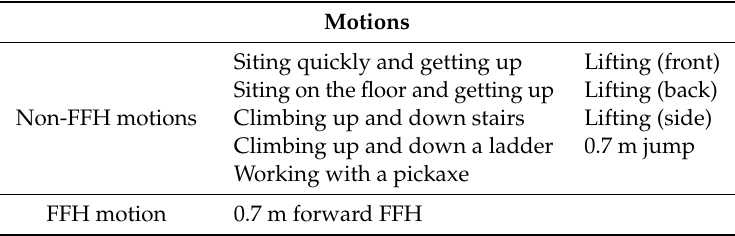
Table 2. List of additional motions in Experiment